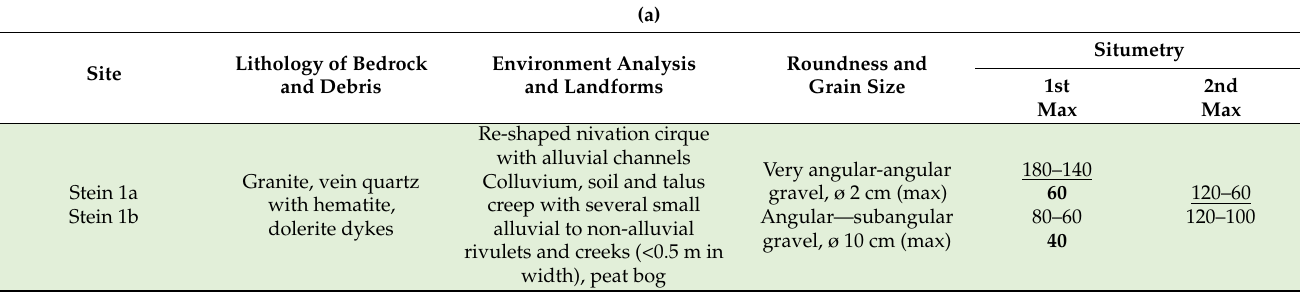
Table 3. The GMS ( G ranulometry- M orphology- S itumetry) tool applied to the fluvial drainage systems under study in the basement as a function of bedrock lithology aimed at environment and landform analysis. ø = size of gravel specimen. In the situmetric columns the 1st and the 2nd maximum are given in degrees. The values denote the angle between the longest axis of the gravel relative to the reference line 0–180 ◦ which is equal the orientation of the width of the channels at the station of measurement. See also semi-circle rose diagrams in Figure 14. ( a ) LGG-Type of the Steinach River in the Fichtelgebirge; ( b ) VLG-Type of the Wilde Rodach River in the